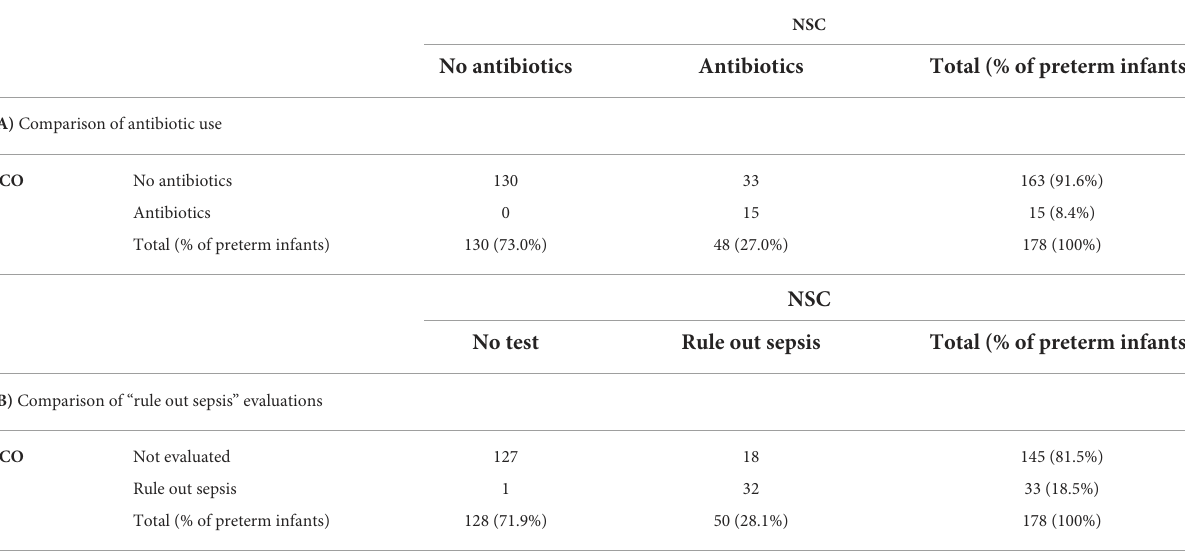
TABLE 5 Comparison of antibiotic use (A) and “rule out sepsis” evaluations (B) as per SCO vs. recommendations of the NSC among late-preterm